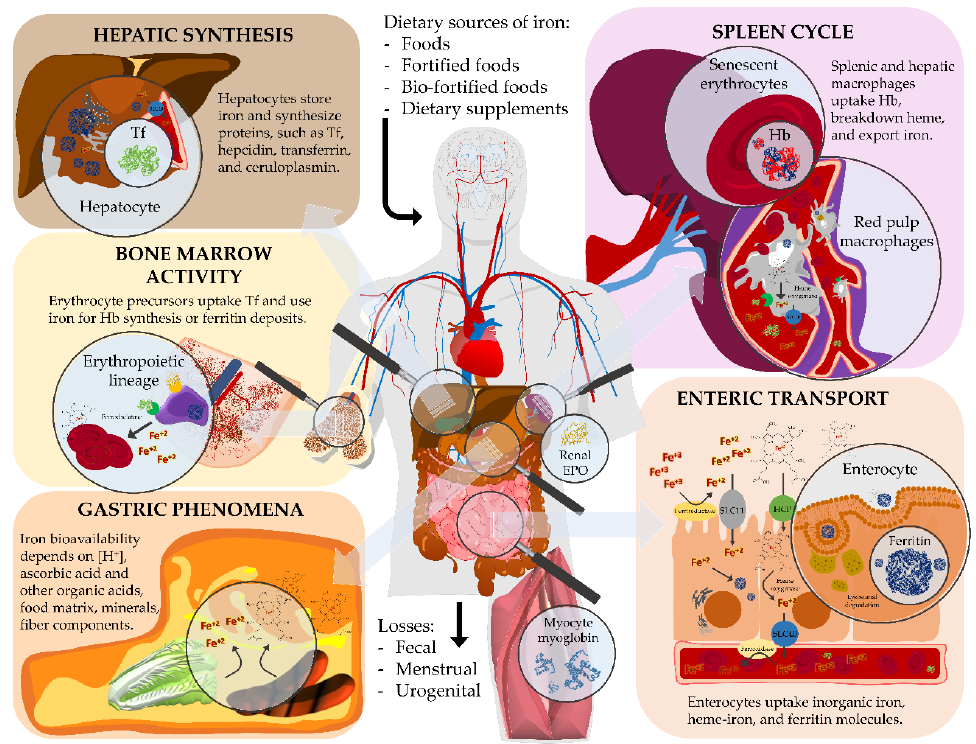
Figure 1. Schematics of the biological pathways of iron with details about major molecules and anatomical sites involved. Dietary iron is absorbed by duodenal enterocytes, circulates in plasma bound to transferrin, and is mainly used to form hemoglobin in newly synthesized red blood cells. Most of body iron is recycled by rep pulp macrophages that engulf senescent erythrocytes and degrade heme to restore circulating transferrin saturation. Iron deposits are mainly at the level of intestines and liver, whereas bone marrow and spleen represent the initial and ultimate step of iron metabolism, respectively. Hb = hemoglobin; Tf = transferrin; SLC11 = proton-coupled metal ion transporter; HCP = heme carrier protein; SLC40 = basolateral transporter ferroportin; EPO =